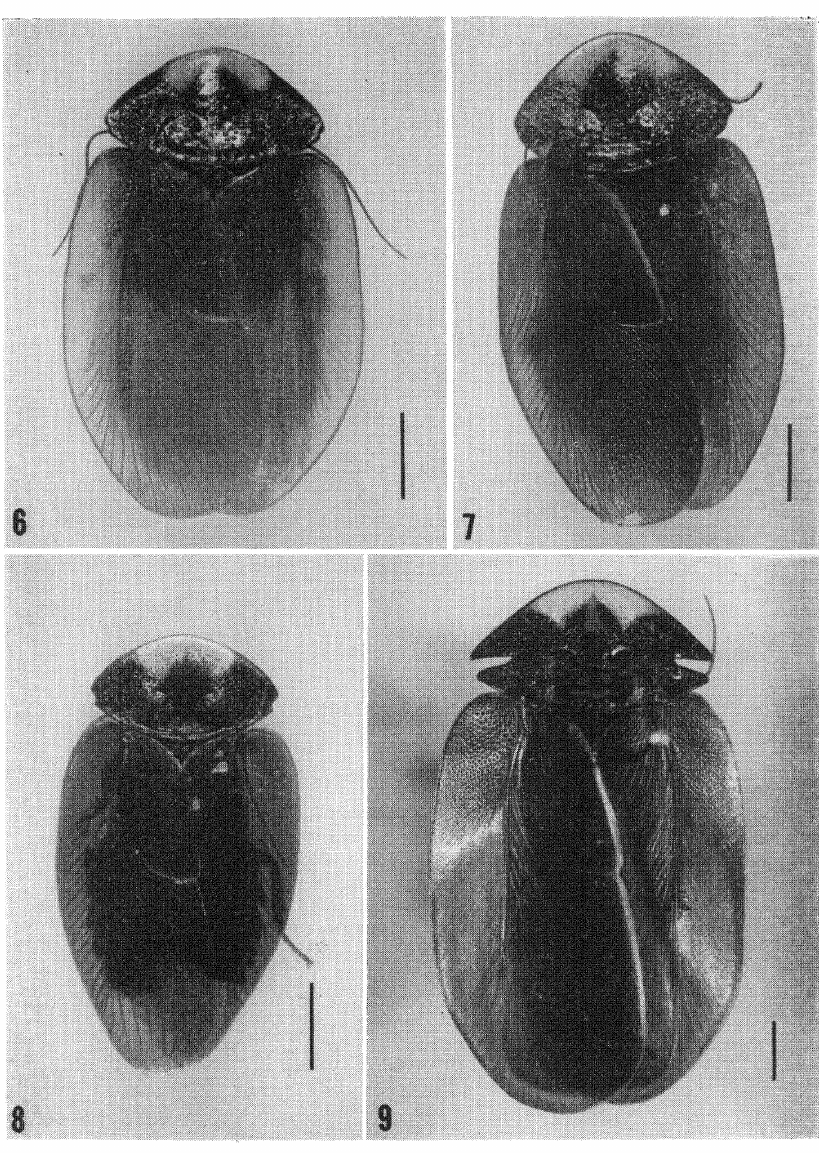
Figs. 6-9. 6. (5 ANSP). Lanxoblatta lata (Shelford). Muzo, Boyaci, Colombia (det. Hebard). 7. (4 ANSP). Lanxoblatta rater Hebard. Paratype. Antioquia, Colombia. 8. (2 ANSP). Lanxoblatta emarginata (Burm.). La Forestire, Haut Maroni, French Guiana (det. Hebard). 9. (97 ANSP). Schizohilia fissicolis (Serv.). La Forestire, Haut Maroni, French Guiana. (det. Hebard). (scale